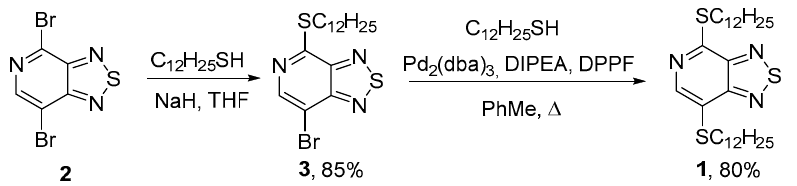
Table 1. Reaction of 4,7-dibromo-[1,2,5]thiadiazolo[3,4- c ]pyridine 2 with dodecane-1-thiol. Entry Solvent Base Time, h Yield, of 3 % 1 CHCl 3 - 6 40 2 THF - MeCN THF NaH 3